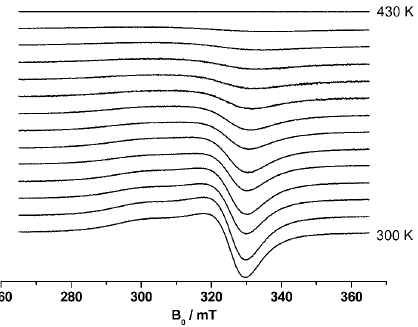
Figure 5. Temperature dependent EPR spectra of (EtPh 3 P) 2 [CuBr 4 ] ( 7 ) recorded in the temperature range from 300 to 430 K (10 K steps).